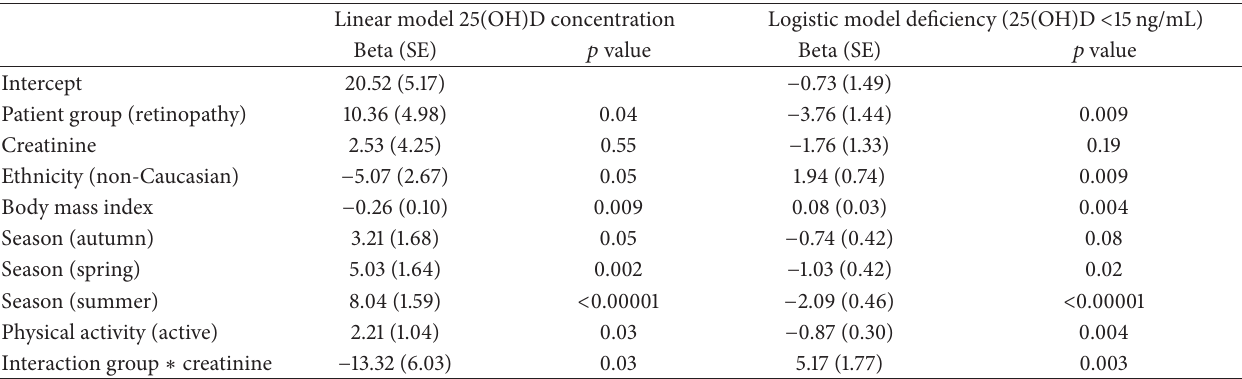
Table 2: Multivariate analysis for the association of the status of retinopathy and 25(OH)D. The relevant parameters and 𝑝 values from the linear and logistic regression models to evaluate the concentrations of 25(OH)D and the presence of vitamin D deficiency (defined as 25(OH)D < 15ng/mL) are shown. For qualitative variables, the category in the model is provided. The reference categories are no retinopathy, Caucasian, Winter and sedentary for patient group, race, season, and physical activity, respectively.